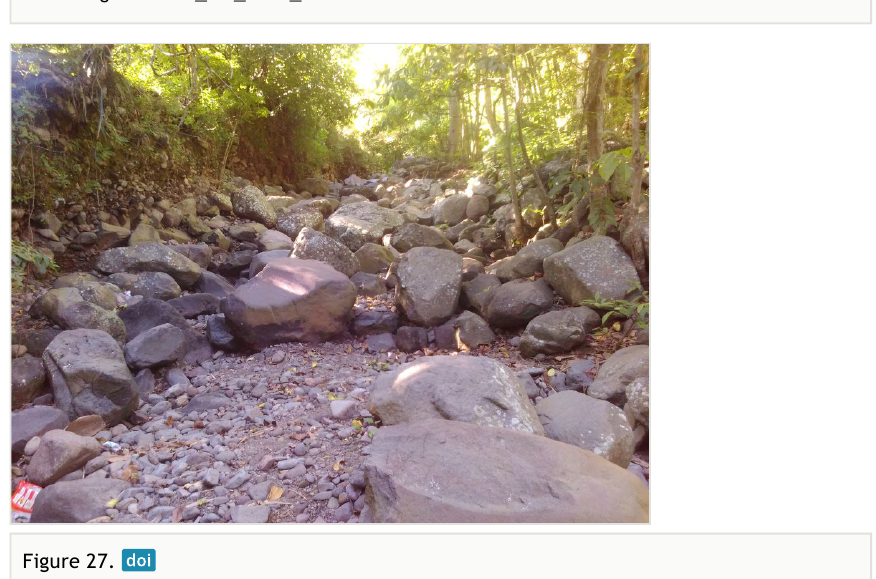
Collecting site BALI_NS_2016_17.